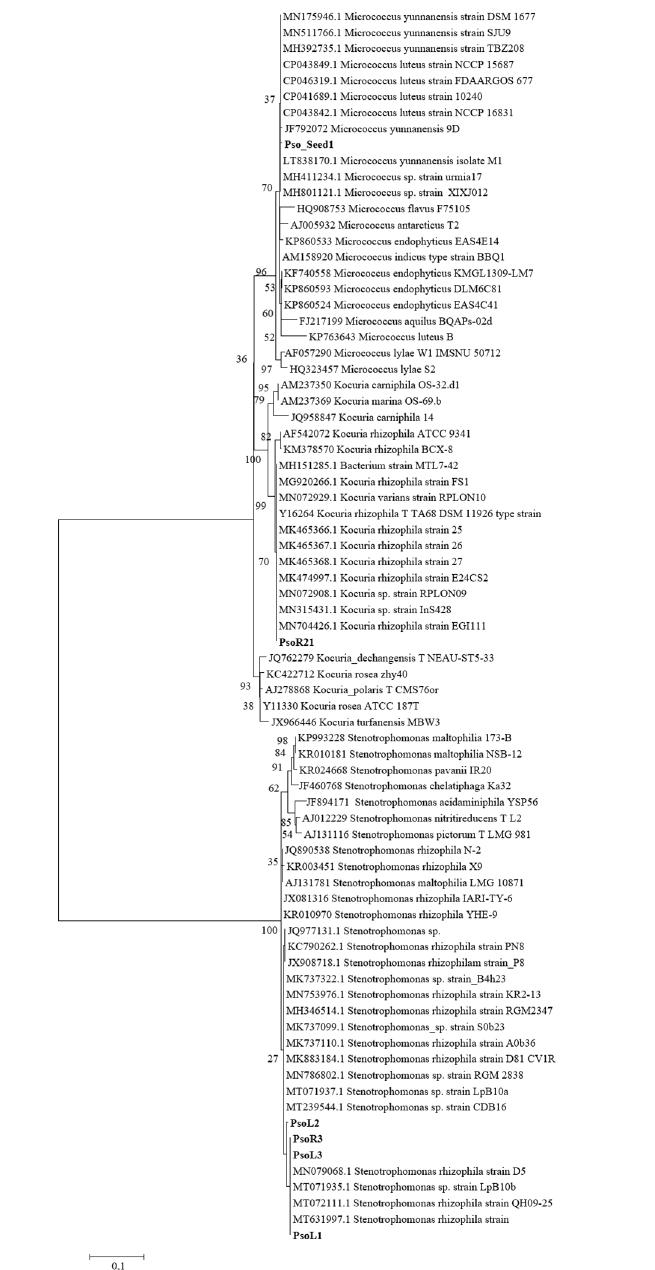
Pso_R12 from the roots and Seed_Pso1 from the seeds, were able to produce the highest amount of IAA, higher than 1 µg for 10 8 cells. The lowest values of the produced IAA were measured for a strain isolated from the roots, Pso_R21 accounting for less than 0.1 µg IAA for 10 8 cells. Overall, among the strains isolated from